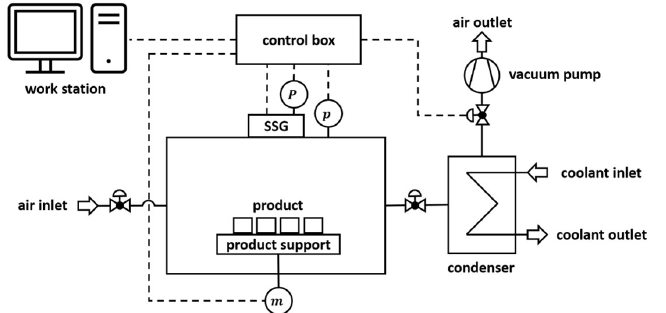
Figure 2. Schematic layout of the laboratory ‐ scale MFD system. Information streams are shown as dotted lines. 𝑃 —forward and reflected microwave power SSG; 𝑝 —pressure capacitive sensor; 𝑚 — mass load cell.